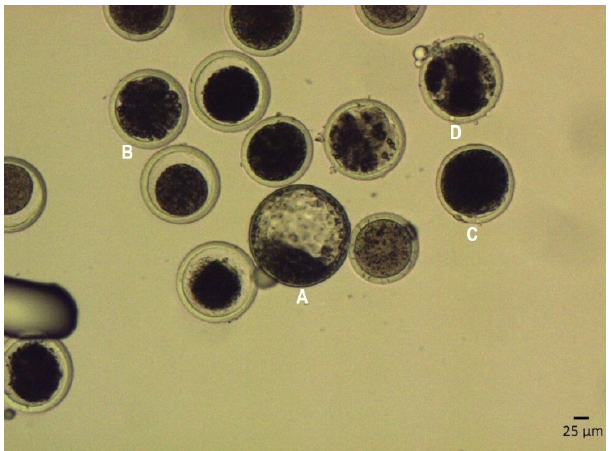
Figure 4. The developmental stage and quality of red deer embryos. ( A ) Blastocyst; complete blastocyst; the cavity fills almost the entire embryo; the trophoblast composed of numerous densely arranged cells that form a coherent layer. ( B ) Morula, embryo with equal blastomeres and several unequal blastomeres, incomplete compaction. ( C ) Unfertilized oocyte. ( D ) Degenerated embryos. The image was taken under phase contrast microscopy at 200× magnification. Scale bar, 25 μ m.